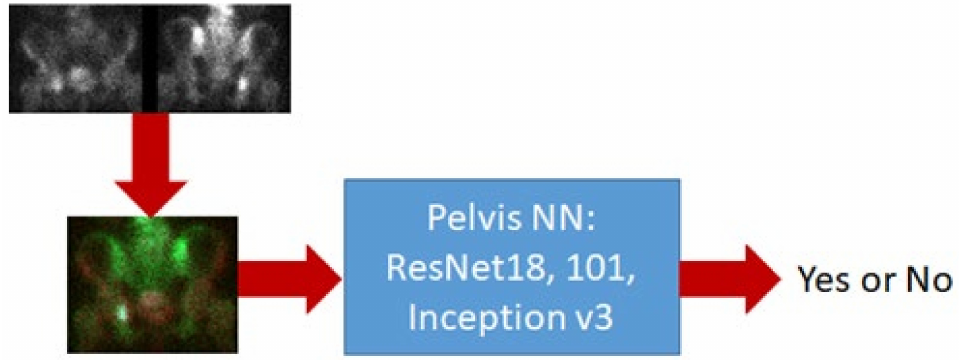
Figure 3. Pelvis NN for metastasis classification. We applied three CNN models for